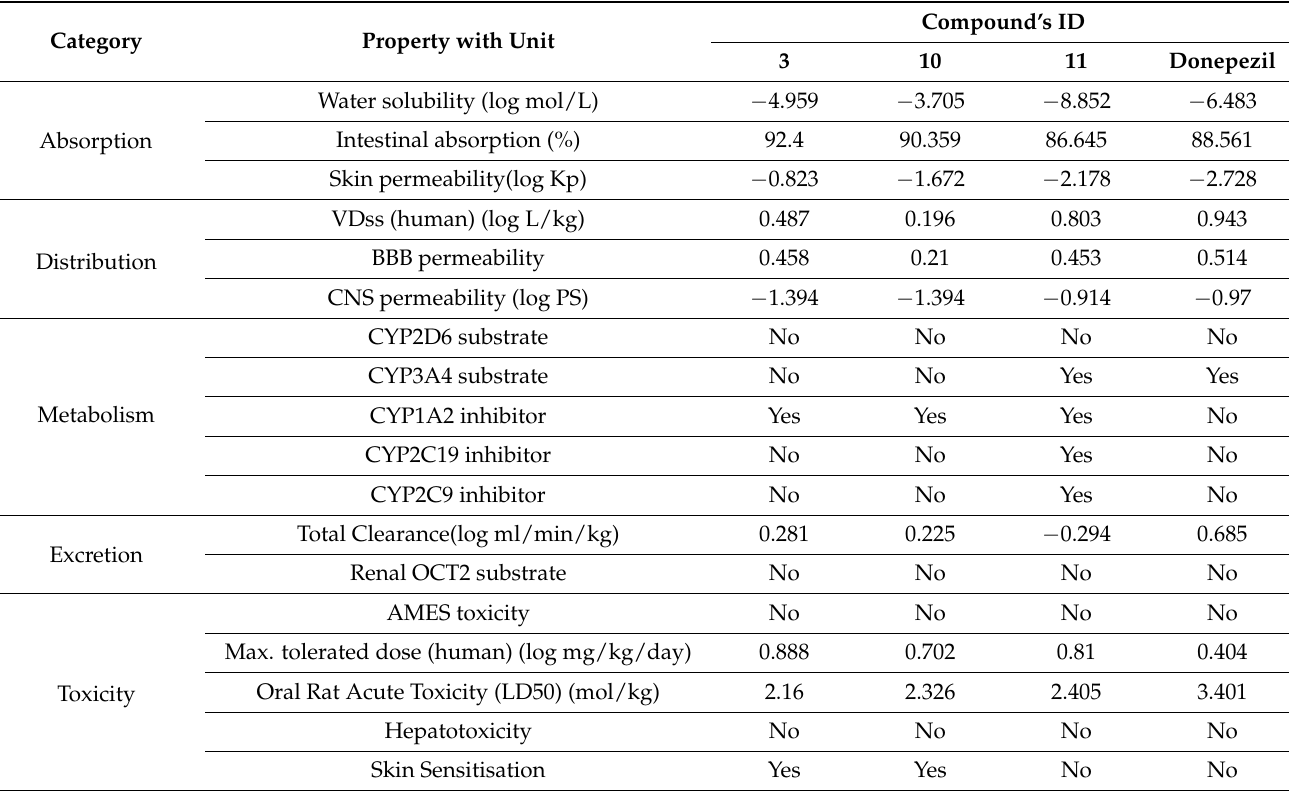
Table 3. Pharmacokinetic (ADMET) properties.